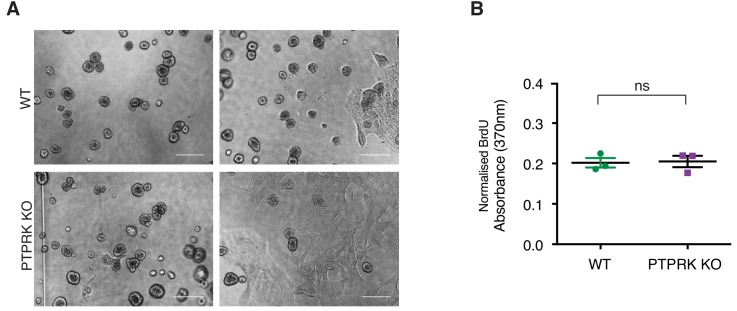
PTPRK loss perturbs epithelial organization.(A) Phase contrast images of wildtype and PTPRK KO MCF10A spheroids after 14 day culture in Matrigel. Scale bars = 200 µm. (B) BrdU incorporation assay performed on subconfluent WT and PTPRK KO MCF10As (n = 3). Unpaired, two-tailed t test: ns = not significant.